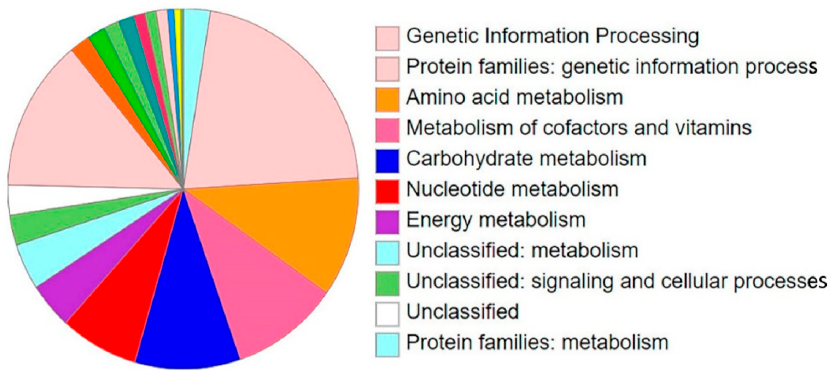
Figure 6. Genes involved in important strategies inside of bacterial species B. velezensis .